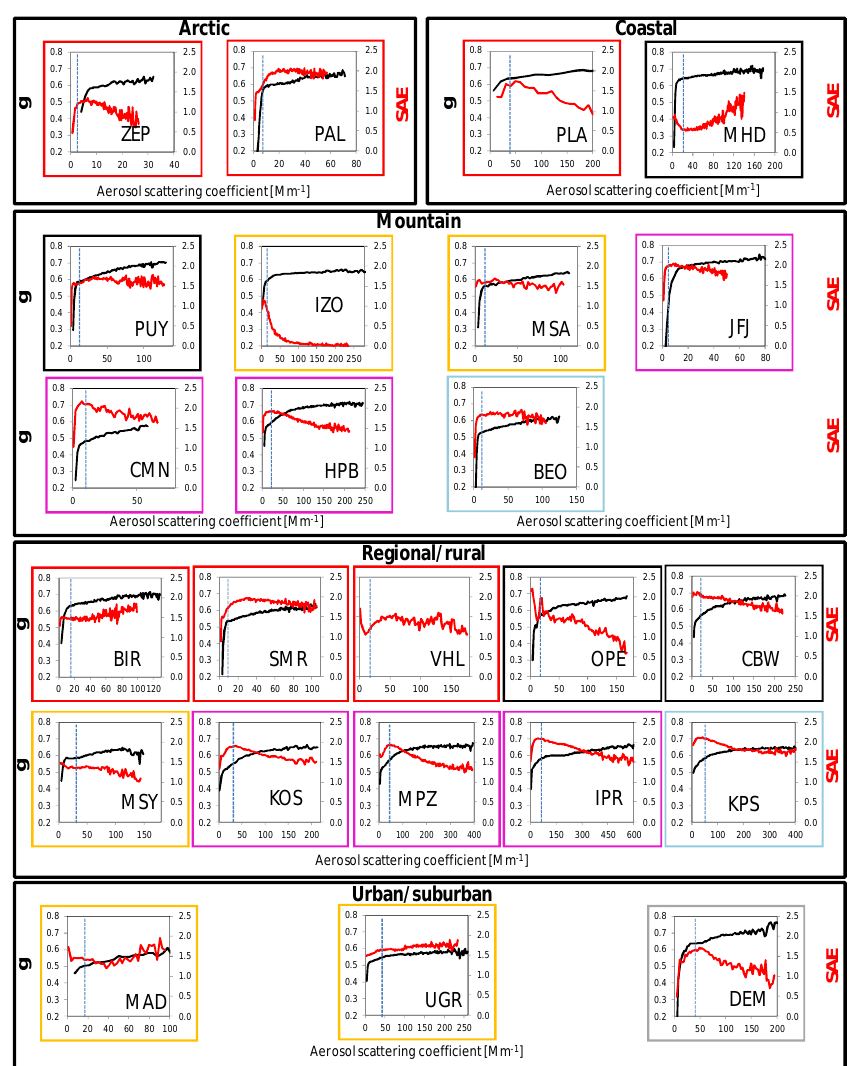
Figure 9. Scatter plots between σ sp ( x axis) and SAE (right y axis; red lines) and g (left y axis; black lines). Dashed lines represent median σ sp values at each station. Different colours highlight different geographical locations as in Figs. 2, 4 and